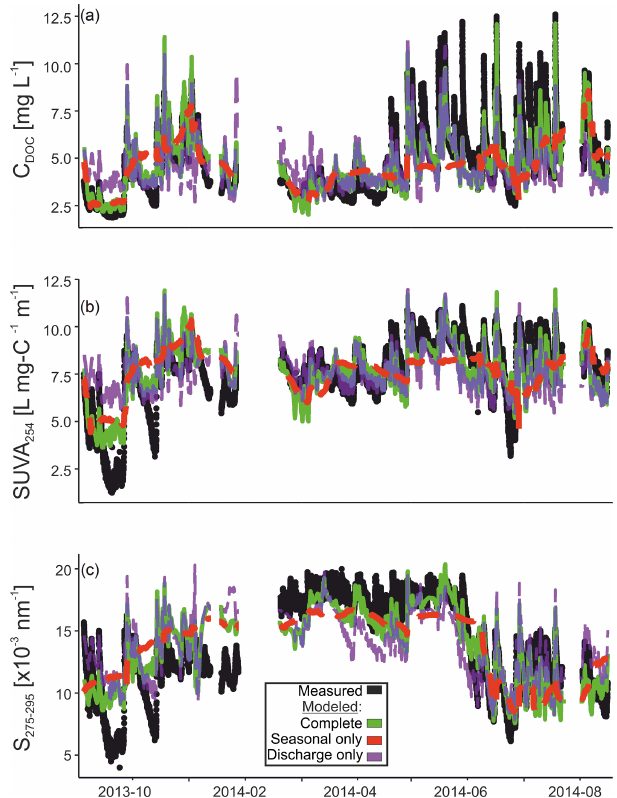
Figure 4. Comparison between measured (black) and multiple re- gression models of the complete predictors (green) as given by Eq. (3), only seasonal predictors AI 60 and DNT 30 plus their interac- tion (red) and only discharge predictors log( Q hf ) and Q b plus their interaction (purple) for (a) C DOC , (b) SUVA 254 and (c) S 275 − 295 values. Complete and discharge only model were smoothed (5- hourly) for better